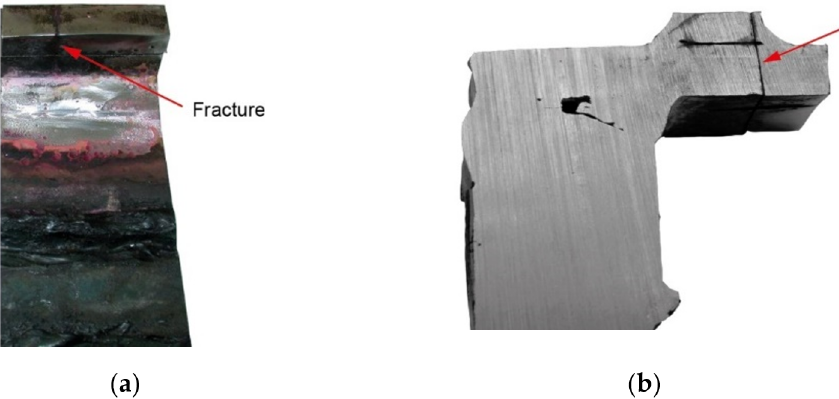
Figure 16. Macroscopic examination of the surface X surroundings (handy-size bulk carrier 30206 DWT): ( a ) the examined bar cut out from parts II and III with a visible crack and ( b ) the lateral surface of the bar cut out (the location of the next cut is shown).